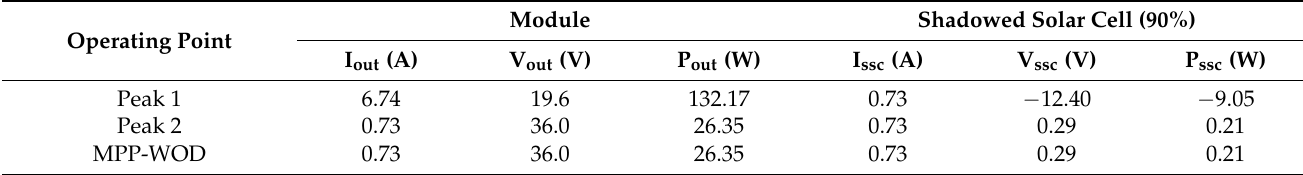
Table 4. Parameters of the shadowed solar cell and the simulated PV module with a solar cell that has a shadow ratio of 90%. Operating